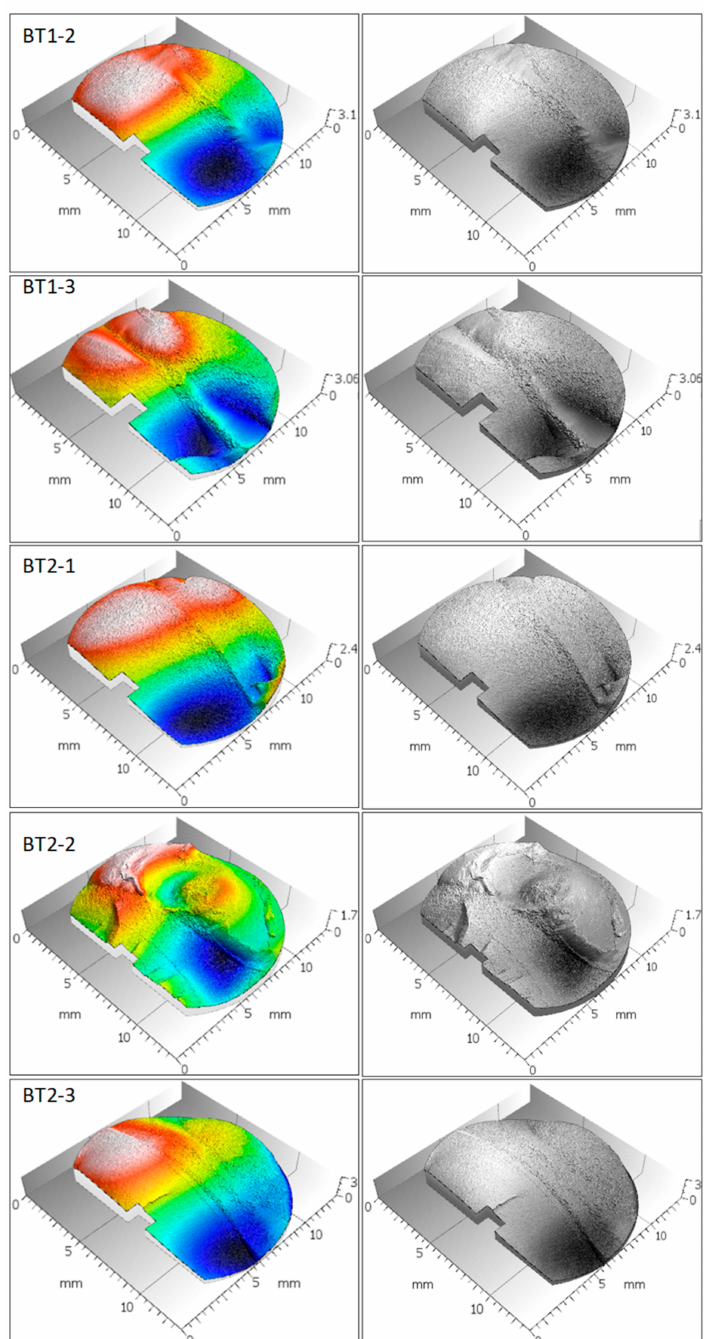
Figure A2. Extracted surfaces of fracture reduced to the region of interest